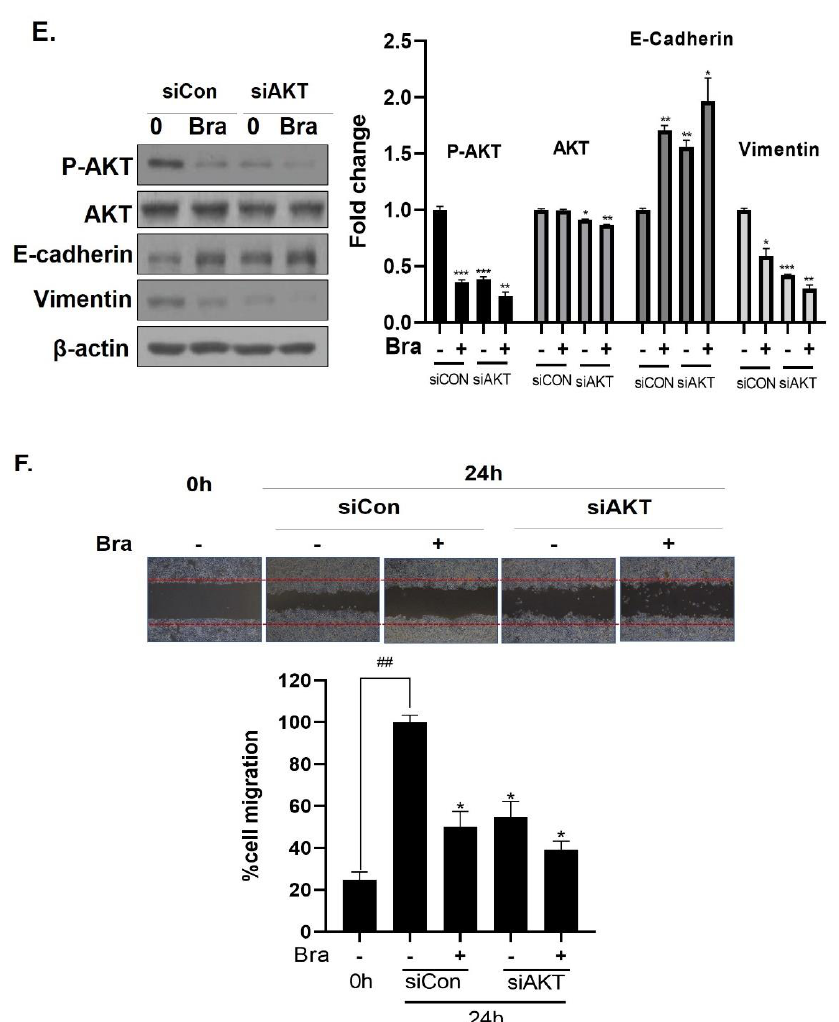
Figure 6. E ff ect of AKT siRNA on cell migration- and proliferation-related makers in Brassicasterol treated prostate cancer cells. ( A – B ) LNCaP cells were transfected with AKT siRNA for 48 h and were incubated in the presence or absence of brassicasterol (10 µ M) for 24 h. ( A ) The cells growth was determined using Cellomax kit. The graph showed quantitative cell growth. (**) p < 0.01 and (***) p < 0.001 compared with control. ( B ) The cell lysates were prepared and subjected to Western blotting to determine the expression of AR p-AKT, AKT, E-cadherin, vimentin, and β -actin. Bar graphs represent the quantification of interest protein related to β -actin, present as a fold change of control of siRNA. (*) p < 0.05, (**) p < 0.01, and (***) p < 0.001 (in comparison to control of siRNA). ( C ) The cells were evaluated to cell migration by wound healing assay. Bar graph represents the quantification of cell migration, present as a percentage of control of siRNA. (*) p < 0.05, (**) p < 0.01 (in comparison to 24h control of siRNA) (##) p < 0.01 (in comparison to 0 h control). ( D – F ) PC-3 cells were transfected with AKT siRNA for 48 h and were incubated in the presence or absence of Brassicasterol (10 µ M) for 24 h. ( D ) The cells were measured cell growth by Cellomax kit. The graph showed quantitative cell growth. (*) p < 0.05, and (***) p < 0.001 compared with control. ( E ) The cell lysates were prepared and subjected to Western blotting to determine the expression of p-AKT, AKT, E-cadherin, vimentin, and β -actin. Bar graphs represent the quantification of interest protein related to β -actin, present as a fold change of control of siRNA. (*) p < 0.05, (**) p < 0.01, and (***) p < 0.001 (in comparison to control of siRNA) ( F ) The cells were evaluated to cell migration by wound healing assay. Bar graph represents the quantification of cell migration, present as a percentage of control of siRNA. (*) p < 0.05(in comparison to 24 h control of siRNA) (##) p < 0.01 (in comparison to 0 h